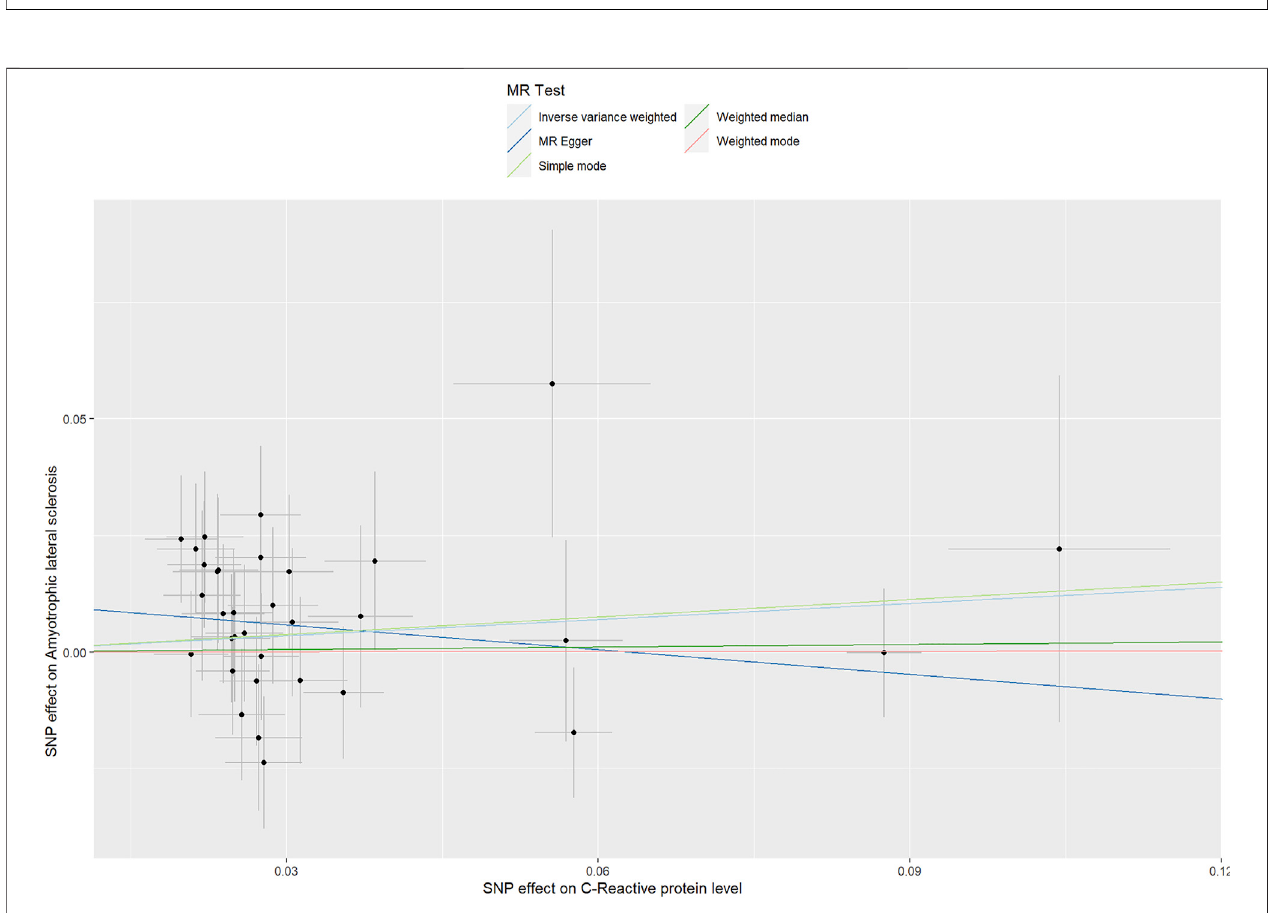
FIGURE 6 | Scatter plots of genetic associations of CRP with ALS risk. The slopes of each line represent the causal association for each method.